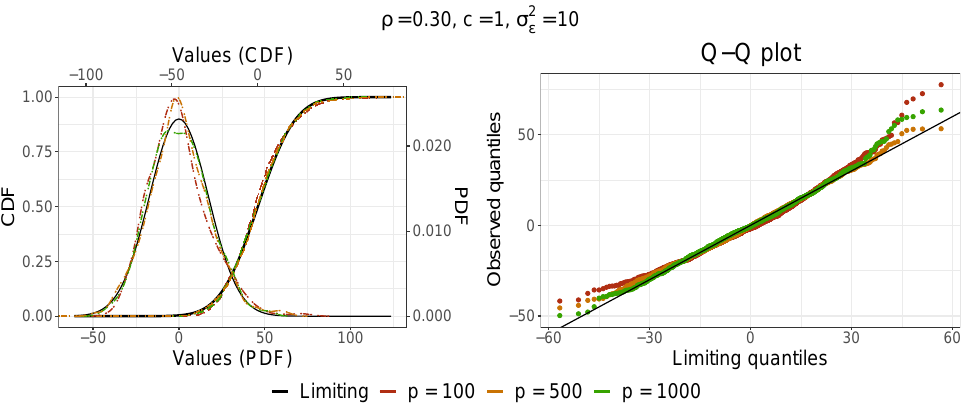
Figure 3. Comparison of the PDF and CDF ( left ) and the corresponding Q-Q plots ( right ) after 1000 replications from the Monte Carlo simulation of the statistic (80) with the limiting distribution N ( 0, s 2 ) by the Corollary 2 (in black) for (cid:36) = 0.3, c = 1, σ 2 = 10 and p = 100,500,1000. ε